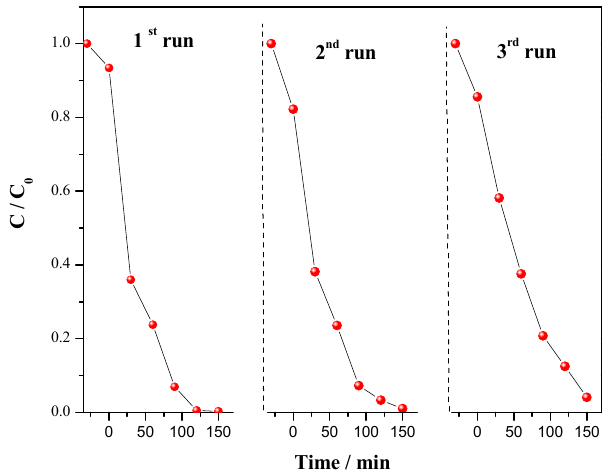
Figure 9. Recyclability of the as prepared green TiO 2 in the photocatalytic degradation of MB.